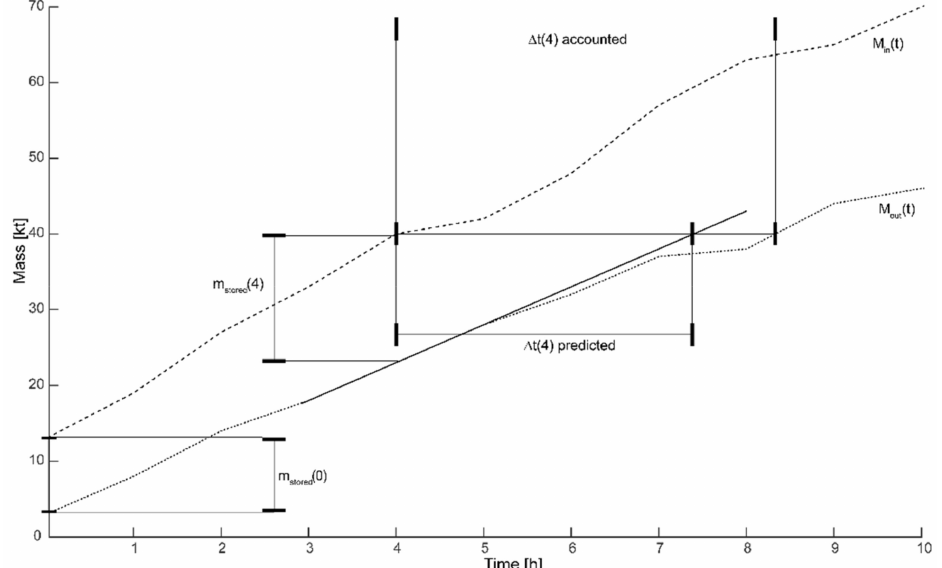
Figure 4. Graphical representation of the cumulative mass inflow M in ( t ) (dashed) and cumulative mass outflow M out ( t ) (dotted). The transportation time is calculated at time 4. The horizontal distance of M in (4) and M out ( t ) represents the back-calculated time. The predicted time is the horizontal distance between the M in (4) and the solid black tangential line at M out (4).